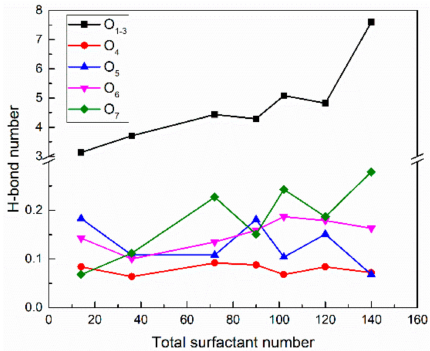
Figure 16. Hydrogen bond numbers between di ff erent oxygen atoms and PVA in SDE 3 S / PVA systems.